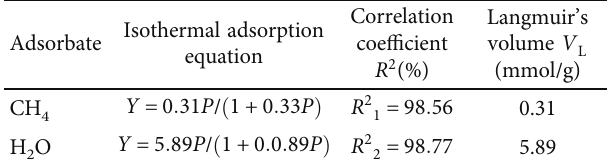
Table 5: Fitting data of di ff erent adsorbates with Langmuir under